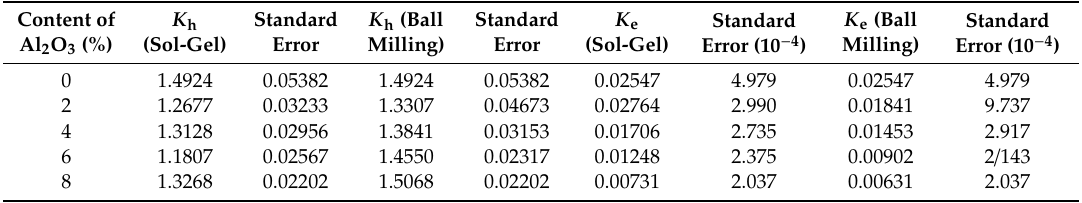
Table 1. K h , K e and their standard error of samples with various content of Al 2 O 3 by different methods.